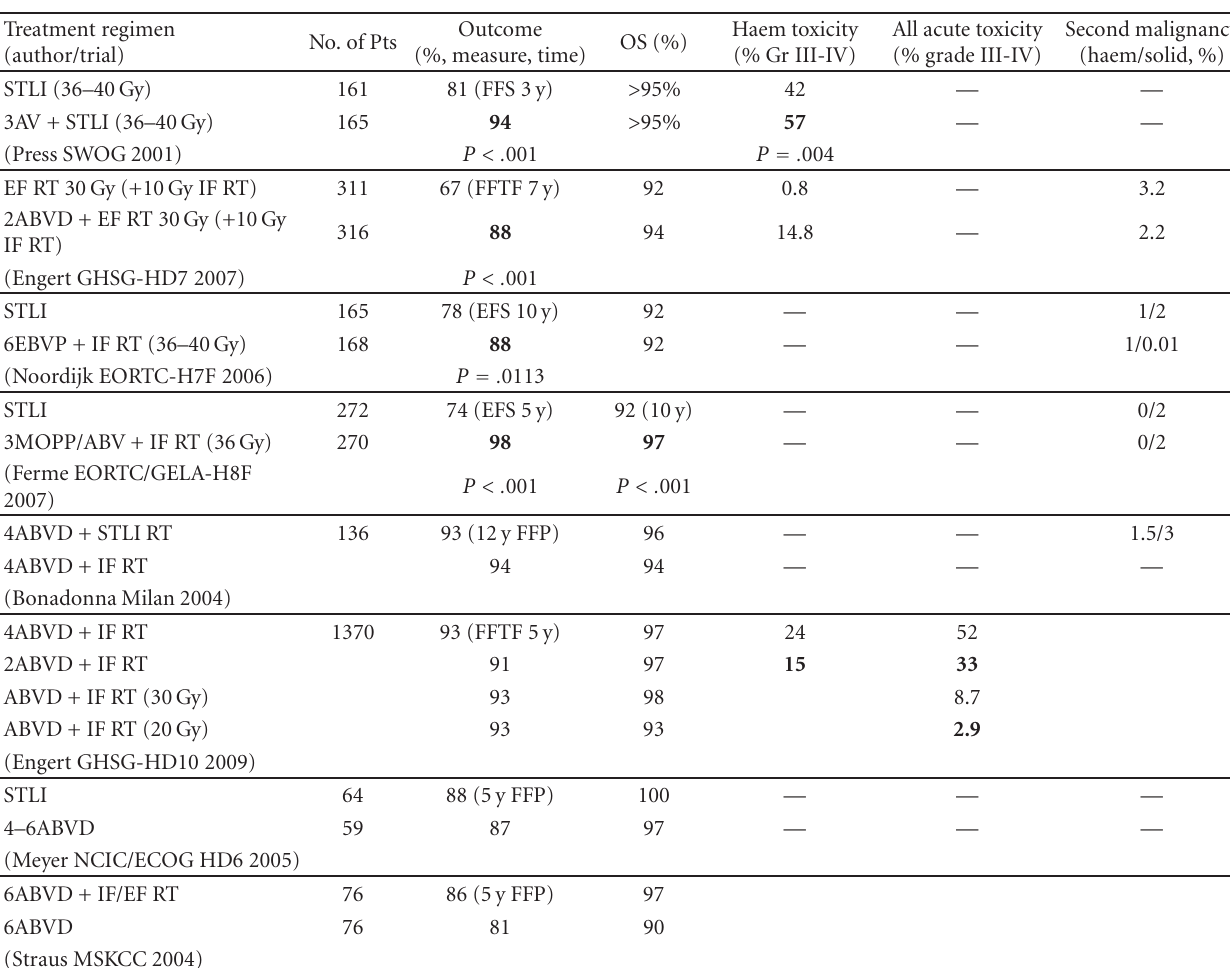
Table 3: Trials of treatments for early stage favourable Hodgkin’s lymphoma. Numbers in bold are statistically significant with P values where significant. Abbreviations: OS: overall survival; EF RT: extended-field radiotherapy; IF-RT: involved-field radiotherapy; STLI: subtotal lymphoid irradiation; Gy: gray; ABVD: doxorubicin, bleomycin, vinblastine, and dacarbazine; AV: doxorubicin, vinblastine; EBVP: epirubicin, bleomycin, vinblastine, and prednisolone; MOPP/ABV: mechlorethamine, vincristine, procarbazine, prednisolone, doxorubicin, bleomycin, and vinblastine; SWOG: Southwest Oncology Group; GELA: Group d’Etudes des Lymphomesle l’Adulte; NCIC: National Cancer Institute of Canada; ECOG: Eastern Co-operative Oncology Group; MSKCC: Memorial Sloan Kettering Cancer